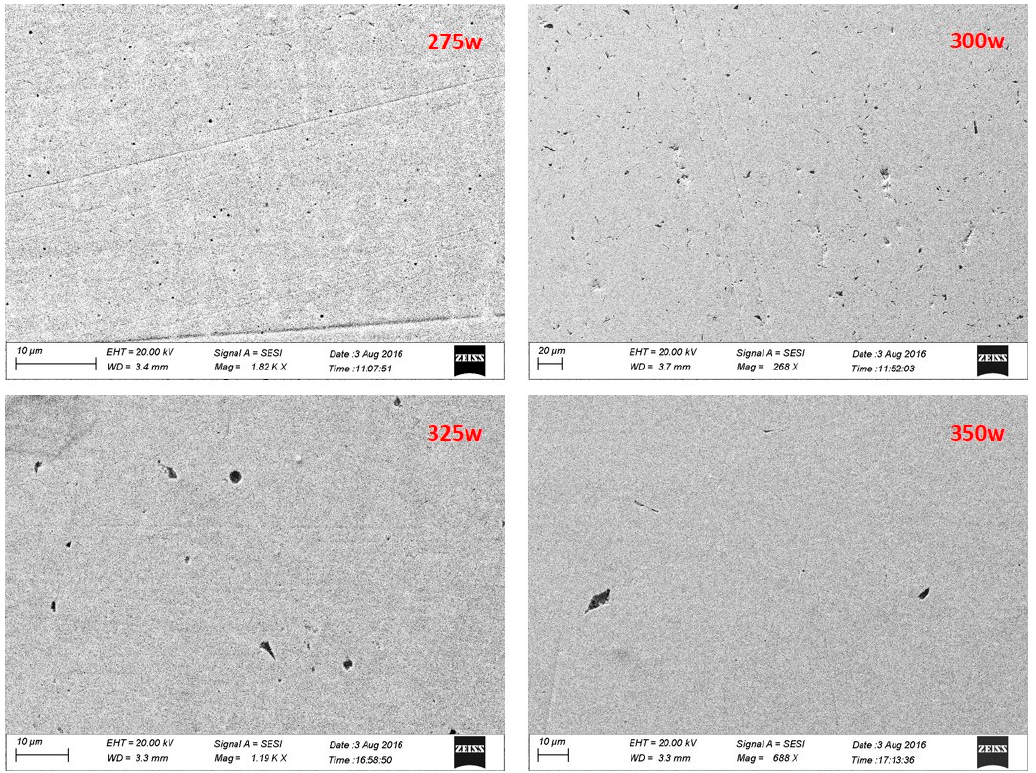
Figure 4. Porosity of the surface layer under different laser power (scanning speed: 8.47 mm/s, powder feed rate: 4 rpm).